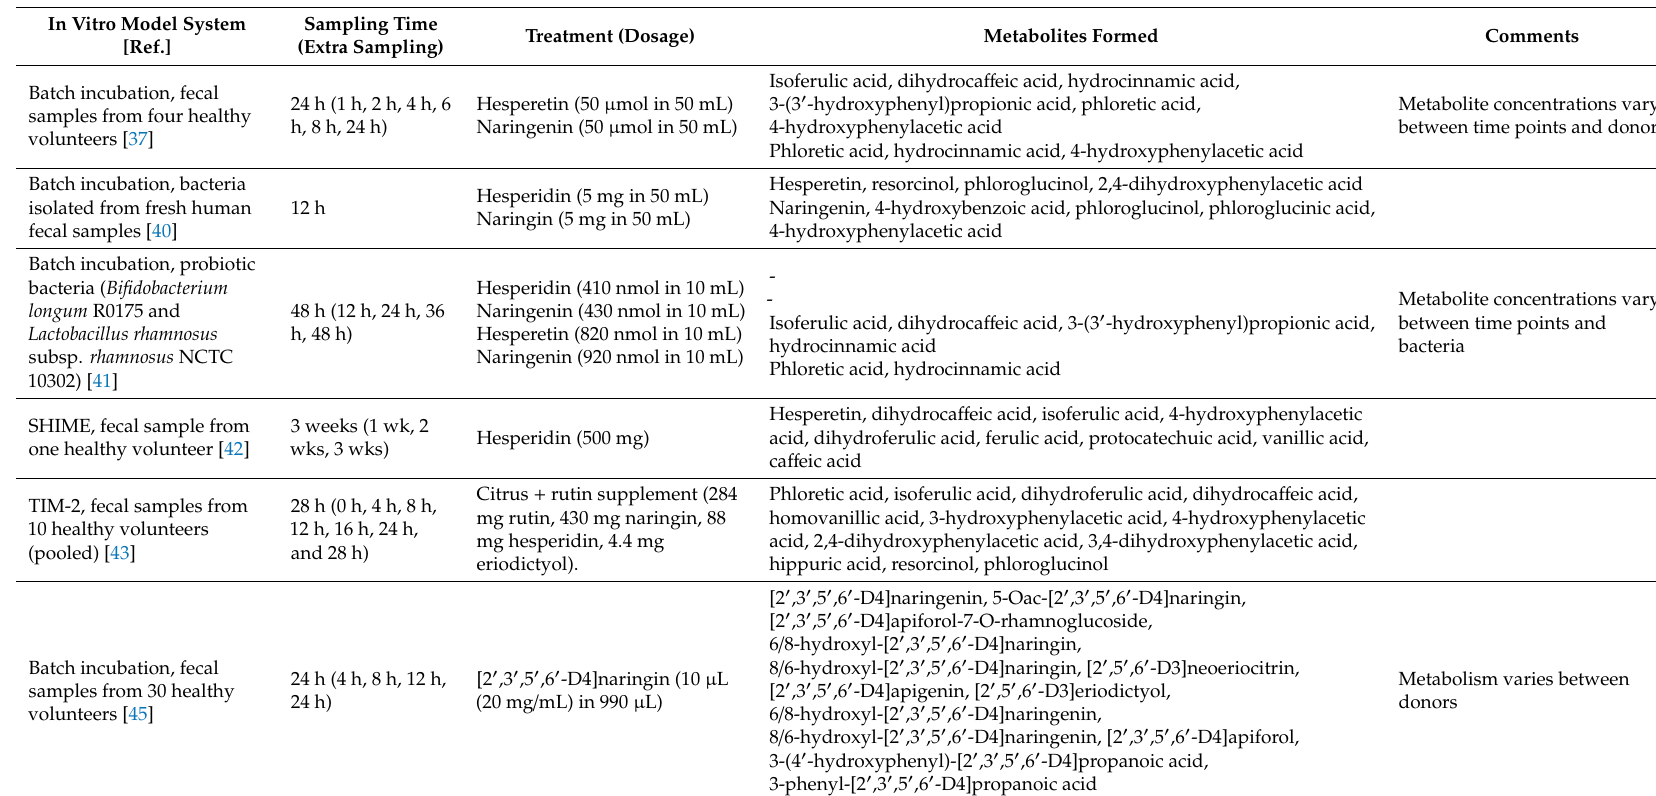
Table 1. Nonexclusive listing of in vitro studies investigating the colonic metabolism of citrus flavanones. In Vitro Model System